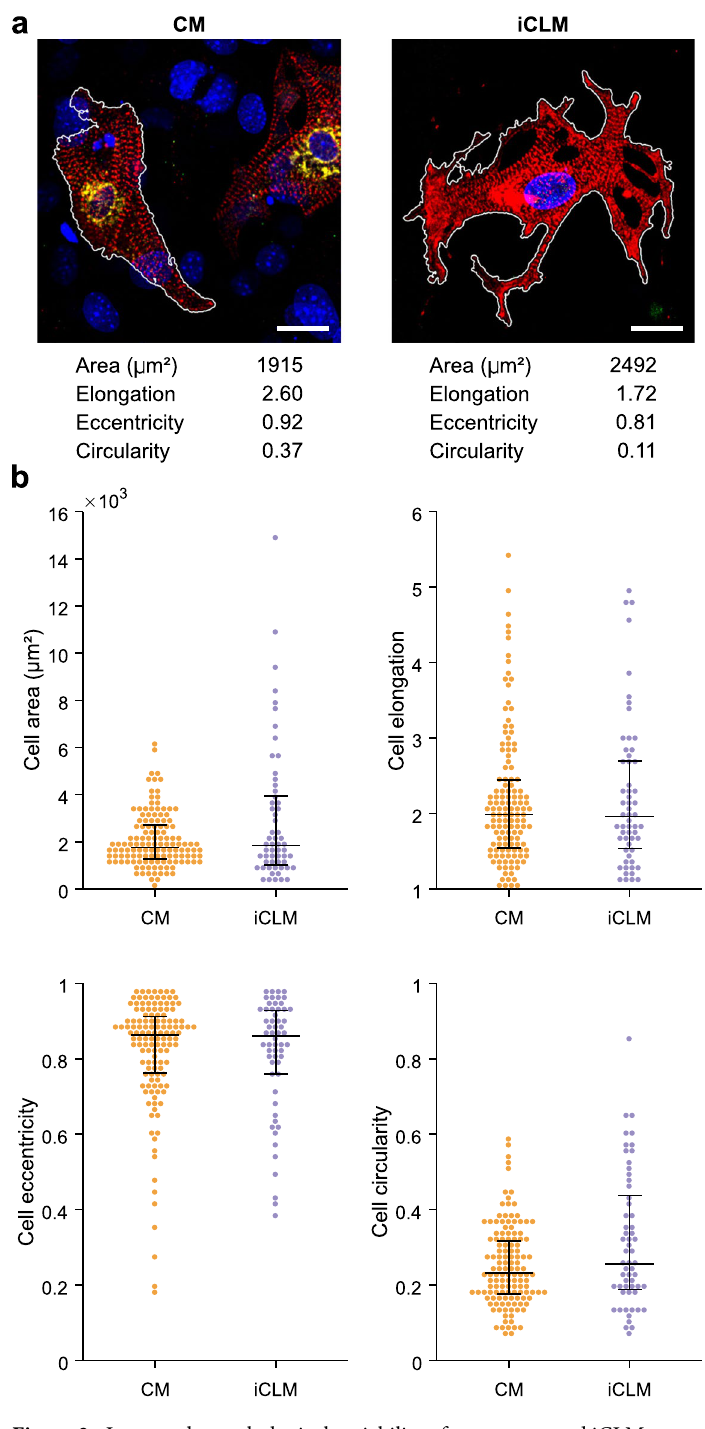
Figure 2. Increased morphological variability of reprogrammed iCLMs compared to endogenous CMs. ( a ) Segmented immunofluorescence images of endogenous CMs (left) and reprogrammed iCLMs (right), with automated morphology measurements for these cells below. Scale bar = 20 μ m. ( b ) Population measurements of various morphological features. Black bars represent 25 th , 50 th , and 75 th